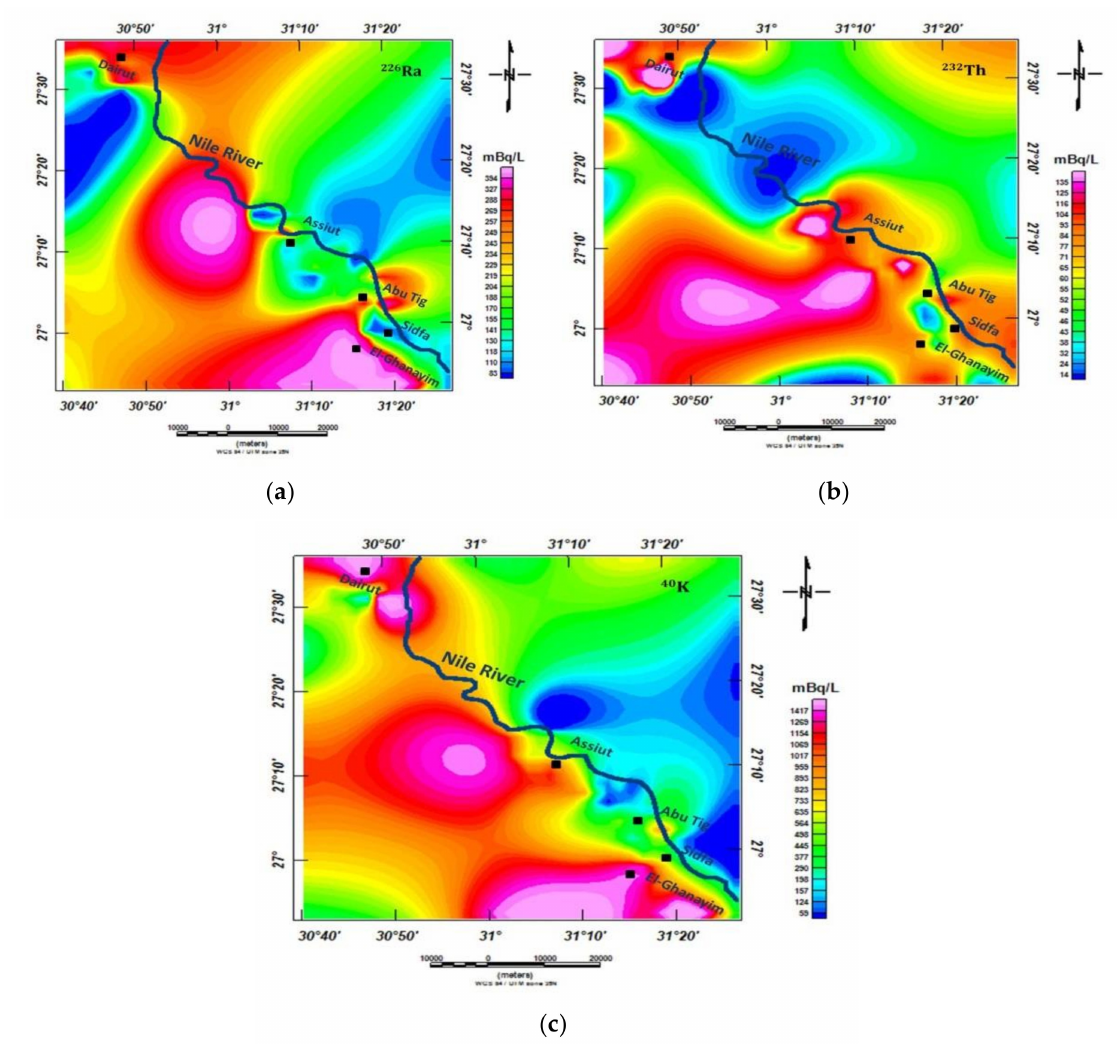
Figure 6. Distribution map of 226 Ra ( a ), 232 Th ( b ), and 40 K ( c ) activity concentrations for water samples,